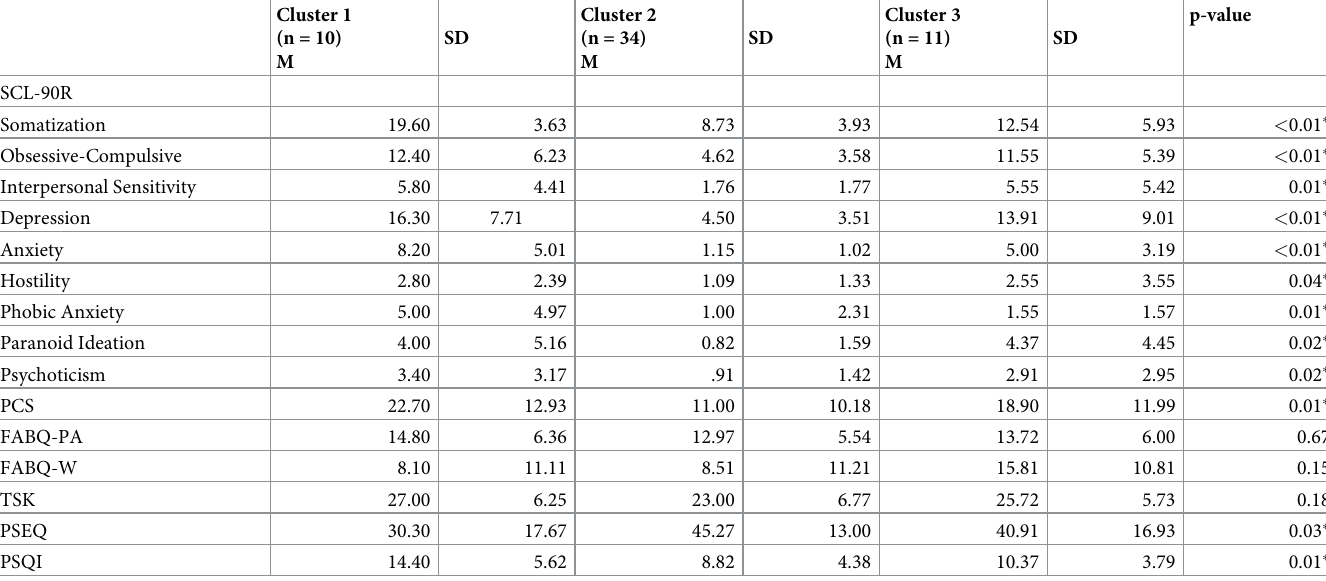
reported significantly poorer sleep patterns compared to Cluster 2 (Cohen’s d = 1.07). Clusters did not significantly differ by FABQ-PA (p = 0.67), FABQ-W (p = 0.15), nor TSK (p = 0.18). Table 3. Total Scores of Pain-related psychological factors by